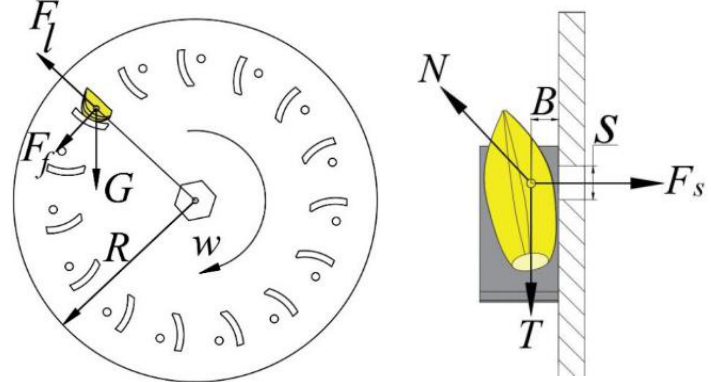
Figure 6. Schematic diagrams of stress analysis of garlic seed adsorption state.